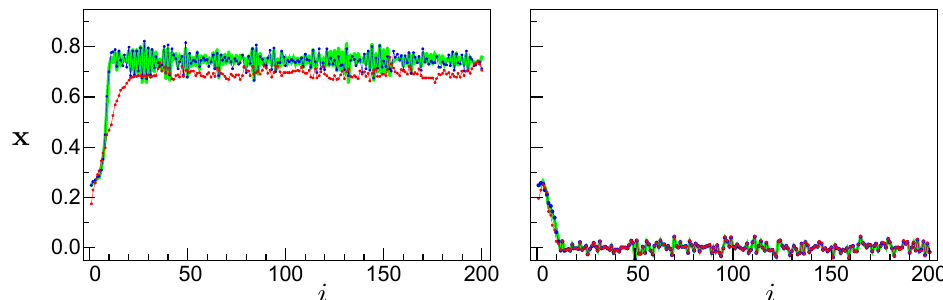
Figure 5: Typical time-series x generated with model (9) (green) compared against the reconstructions by the ENCA-decoder, using two (red) or three (blue) latent variables. The two time-series were generated with the same set of parameters, α = 5.3 and σ = 0.015. Two statistics are sufficient to encode the information about which attractor has been taken, but at the price of a degraded parameter regression and thus a degraded reconstruction. The data has not previously been used for training the AE.